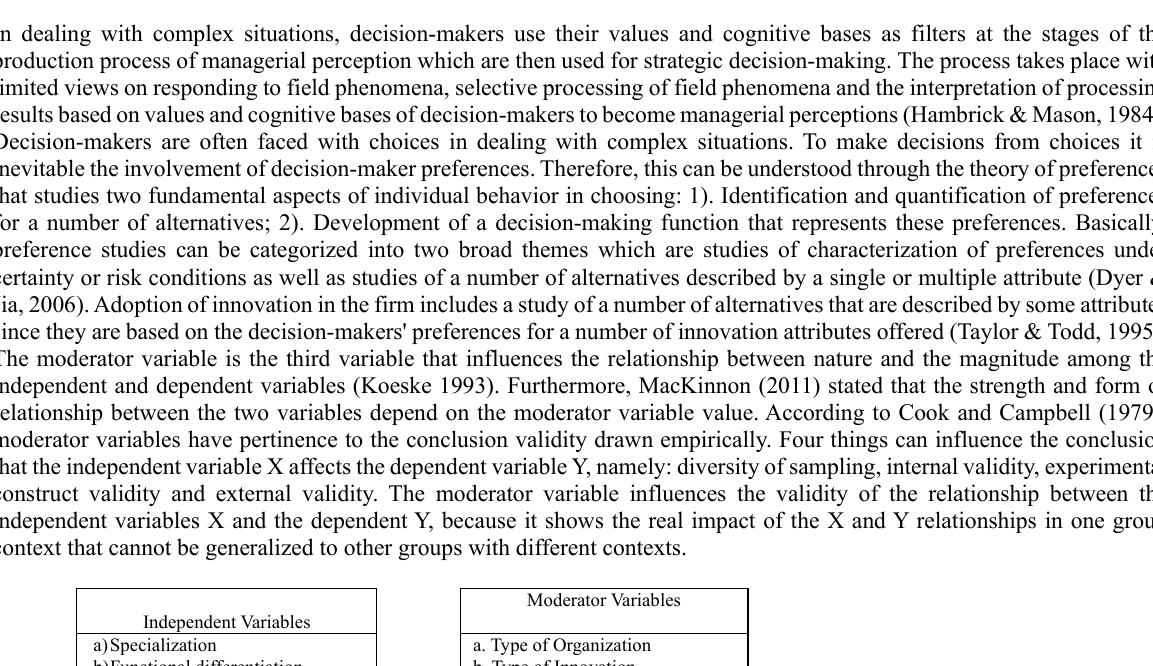
Fig. 1. Strategic choice under condition of bounded rationality (Source: Hambrick & Mason 1984)